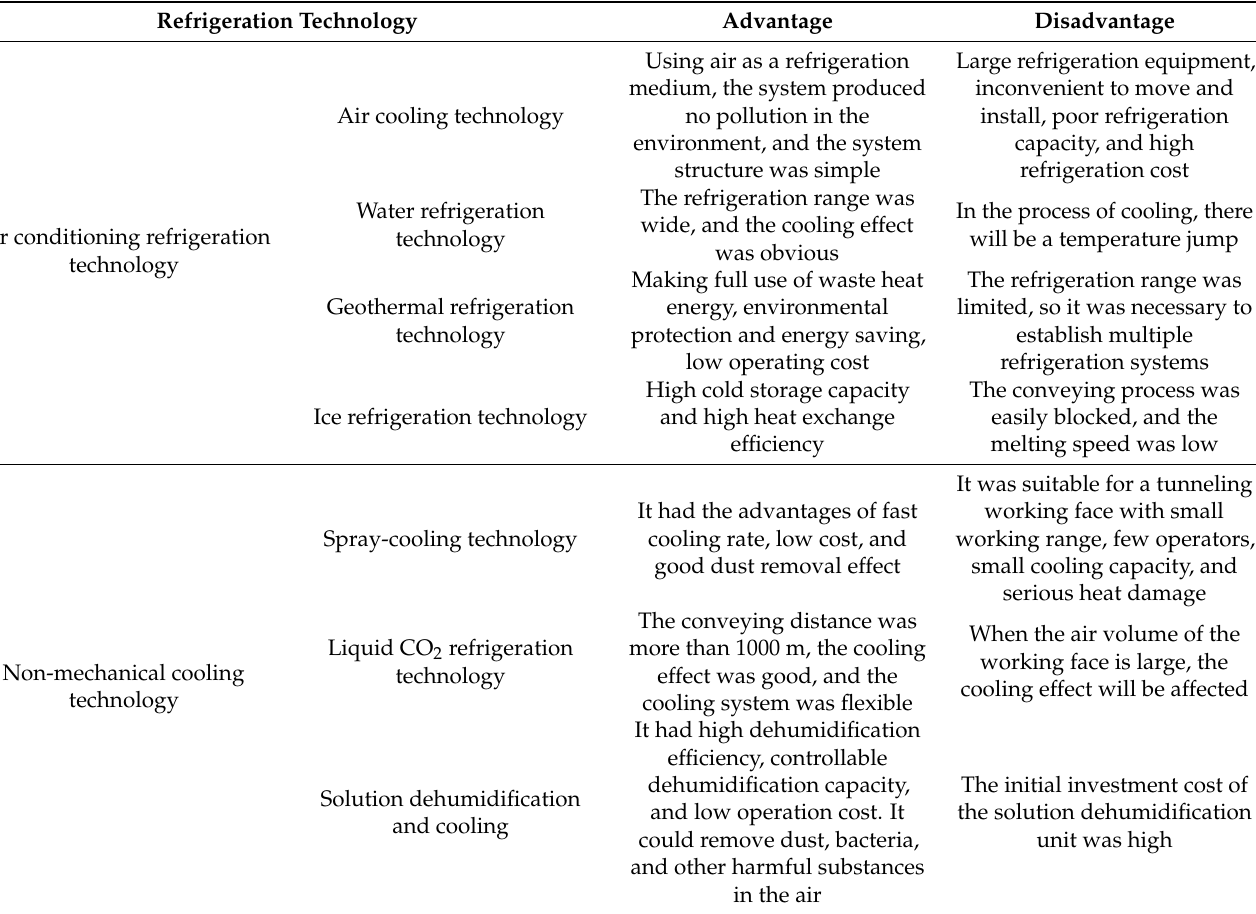
Table 2. Comparison of advantages and disadvantages of refrigeration